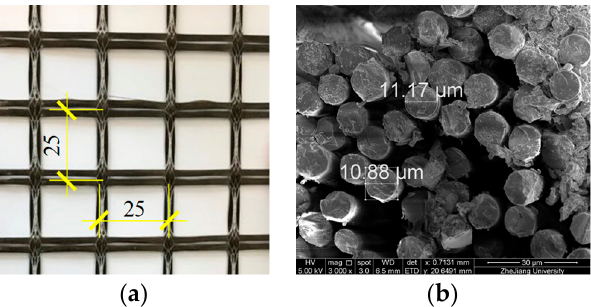
Figure 2. ( a ) the geometry of the textile, mm and ( b ) SEM image of a fiber yarn section.